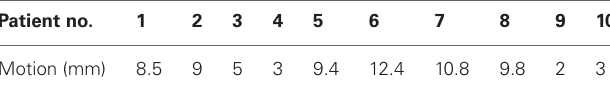
Table 4 | Maximum tumor motion measured on 4D